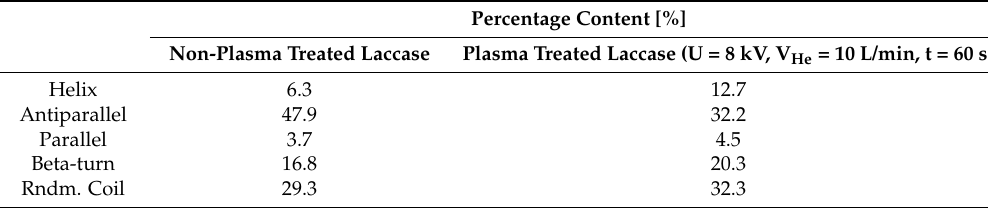
Table 1. The main 2D substructures in laccase molecules before and after plasma treatment.